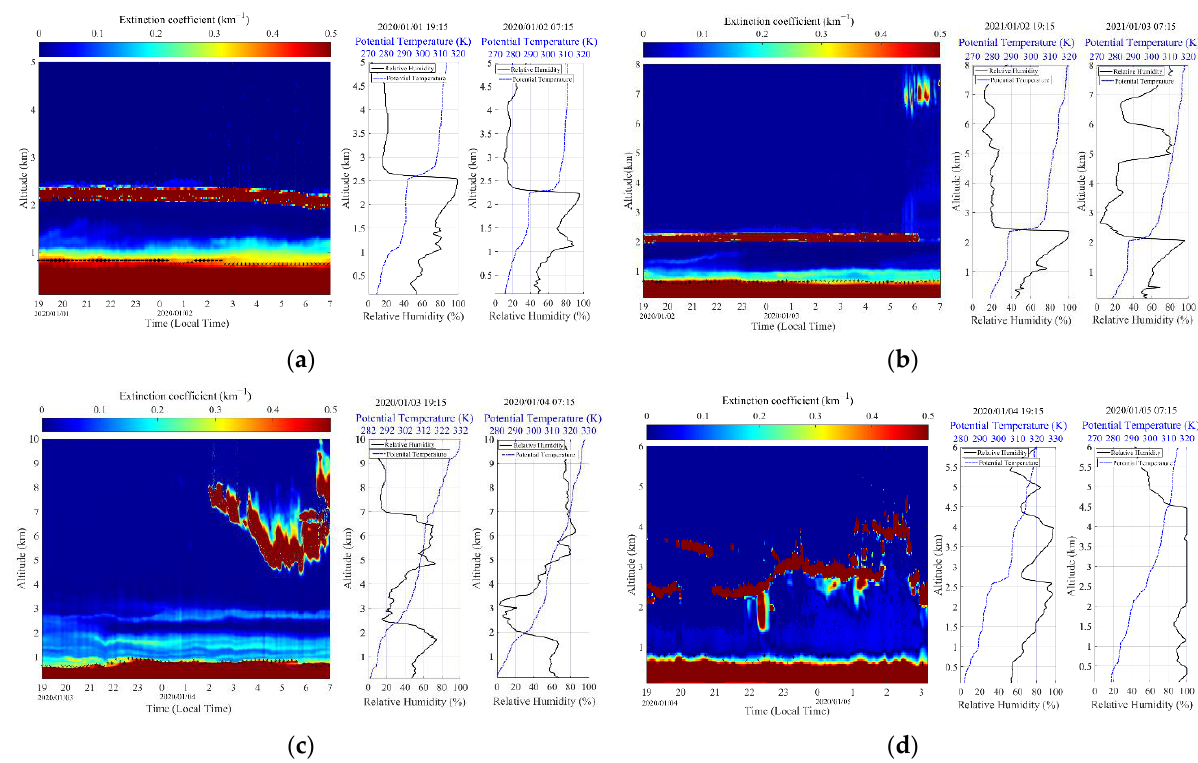
Figure 11. ( a ) THI of aerosol extinction coefficient and profiles of radiosonde data from 19:00 on 1 January to 7:00 on 2